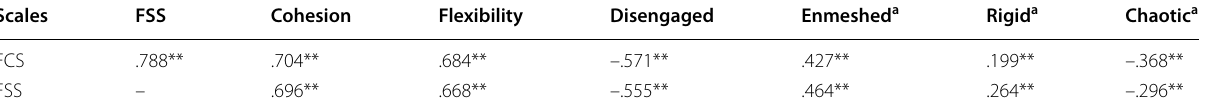
(. a ) Adapted new scales, without deleted items (*) p -value <